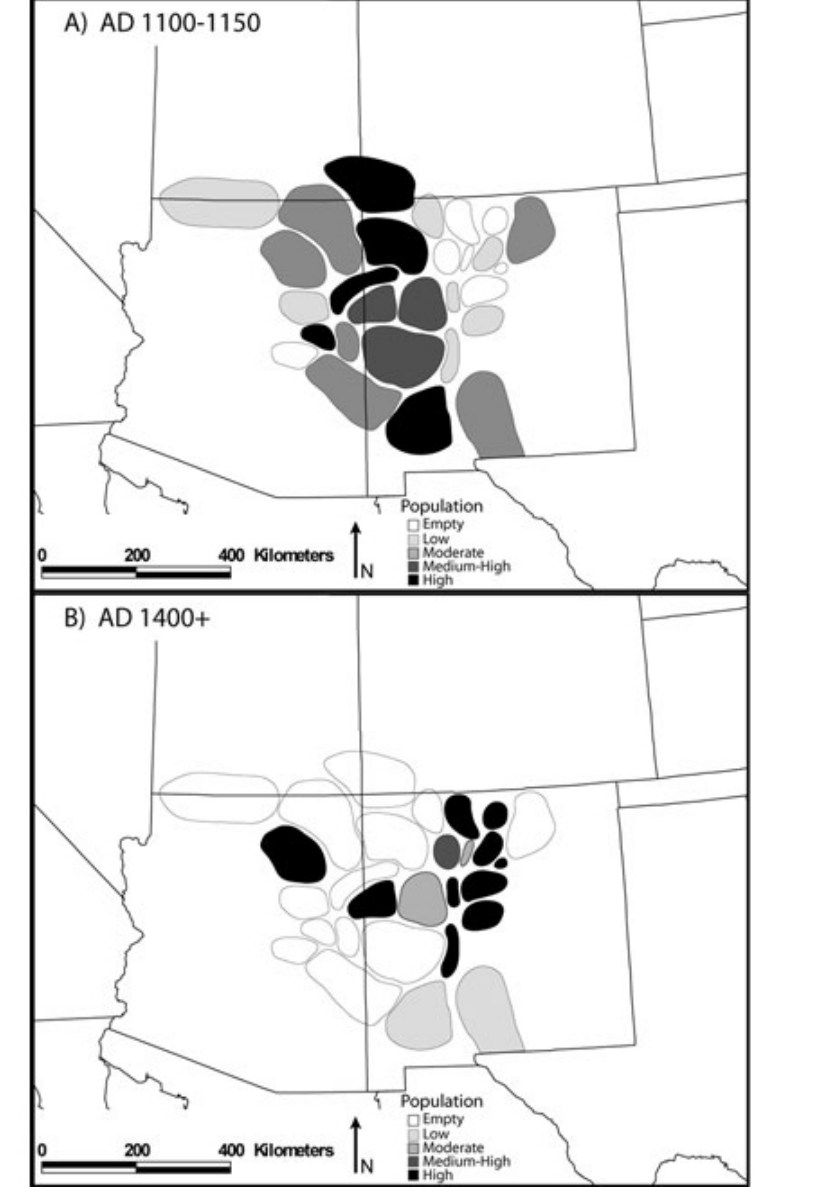
Fig. 8 . Population trends in the prehistoric Southwest. (A) Population concentrations A.D. 1100-1150. (B) Population concentrations after A.D. 1400. After Duff 1998; see Duff for data